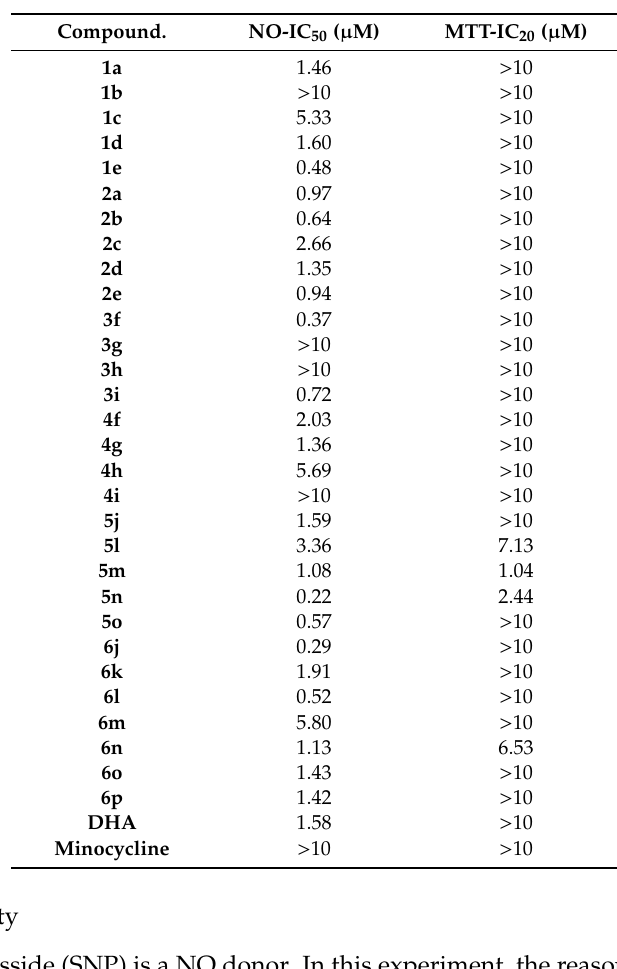
Table 2. IC 50 of tested samples in LPS-induced N9 cells for the inhibition of NO; IC 20 of tested samples in N9 cells for cytotoxic activity.